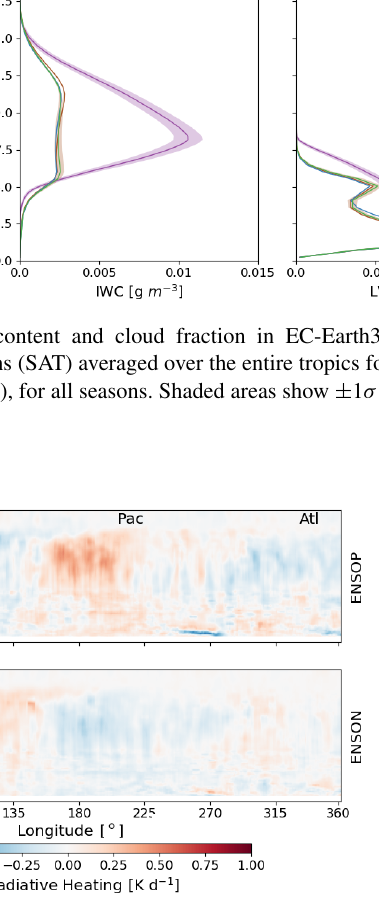
Figure 8. Cloud radiative heating from CloudSat/CALIPSO during the positive (a) and negative (b) phases of ENSO compared to the average between latitude ± 15 ◦ . There is a simple moving average filter applied to the plots to reduce